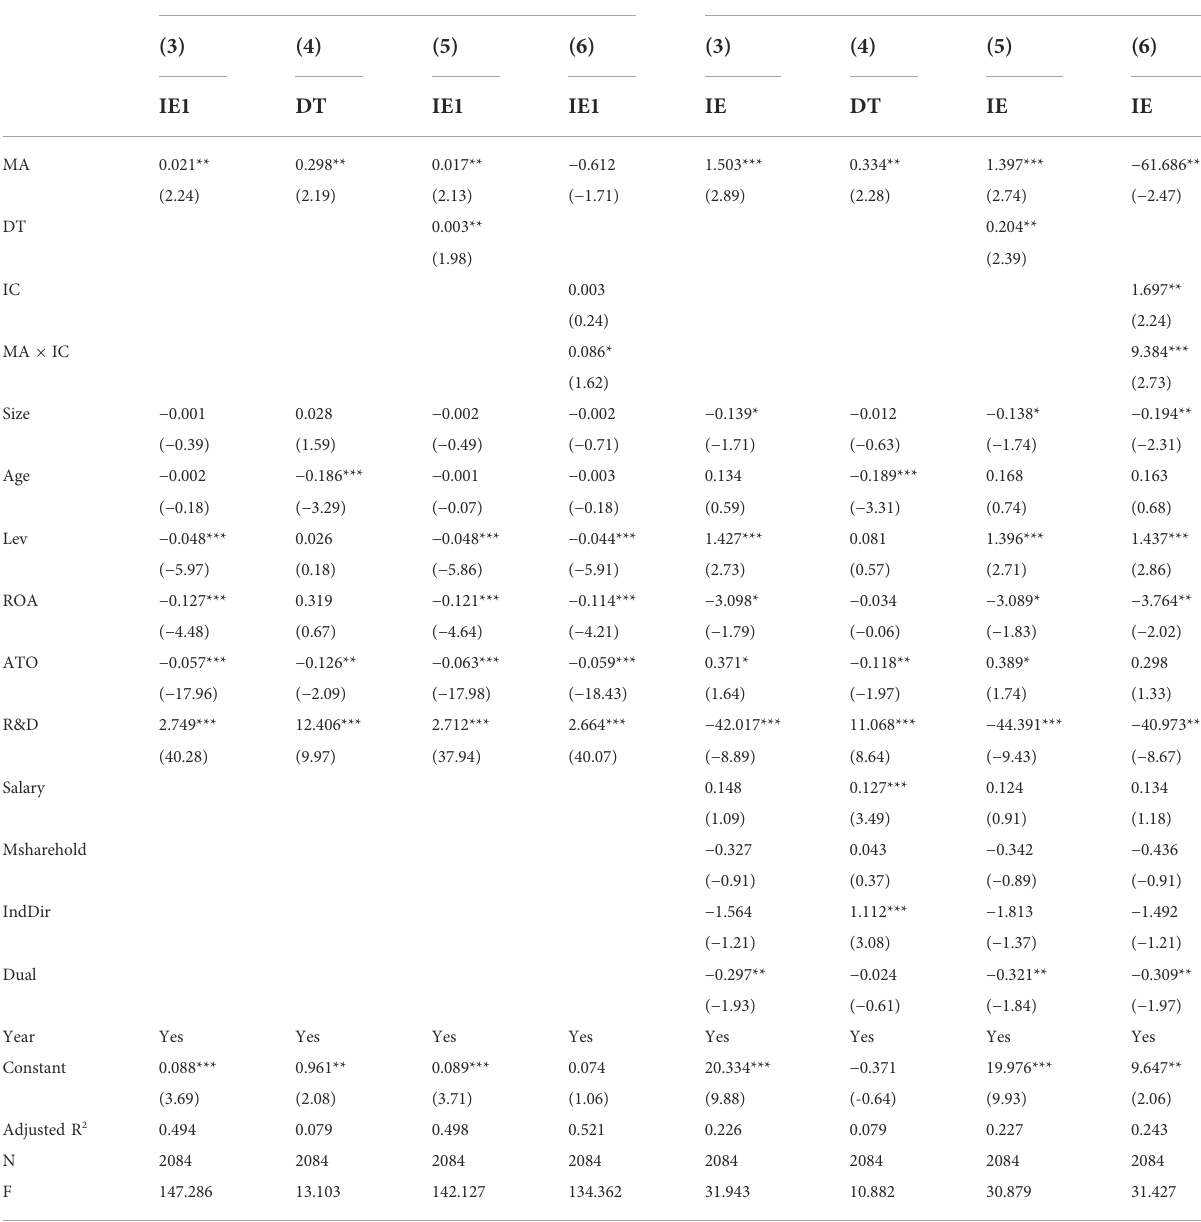
TABLE 5 Robustness